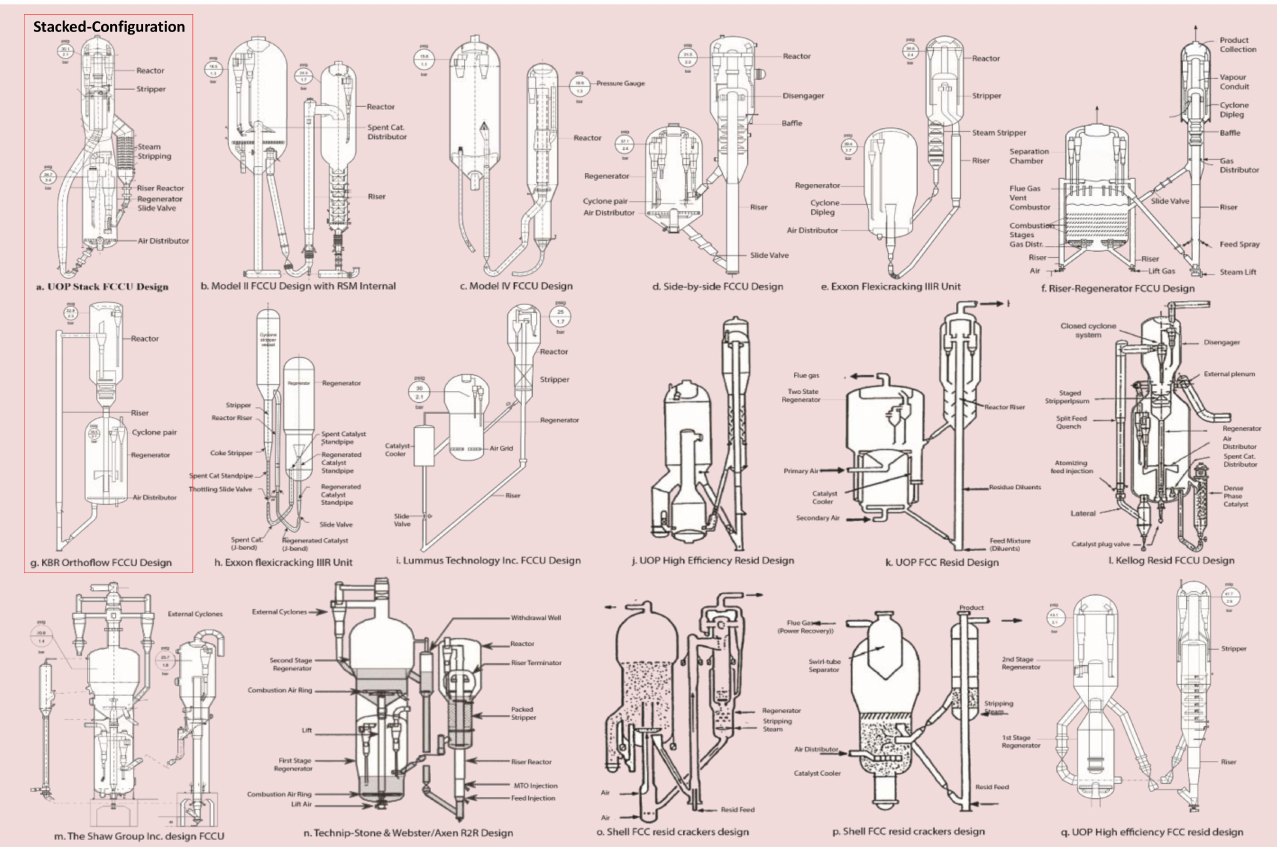
Figure 6. Different commercial FCCU designs. Adopted from Sadeghbeigi [16], Hsu and Robin- son [39], and Chen